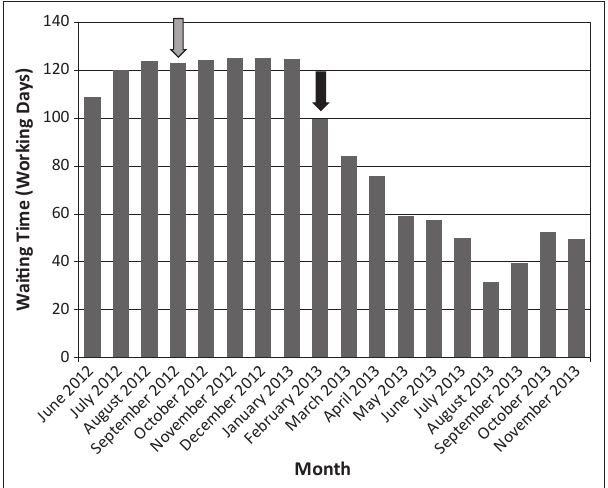
FIGURE 1: Elective MRI waiting time in working days. The grey arrow indicates when longer weekday hours were introduced. The solid black arrow indicates when weekend scanning was